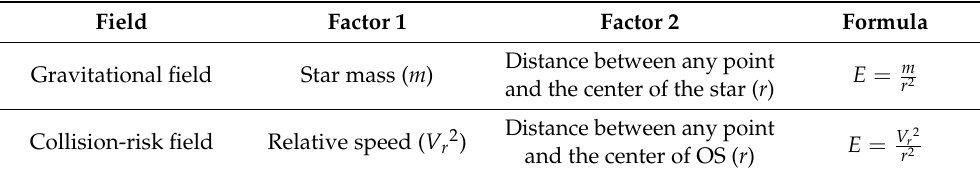
Table 1. Analogy between the gravitational field and collision-risk